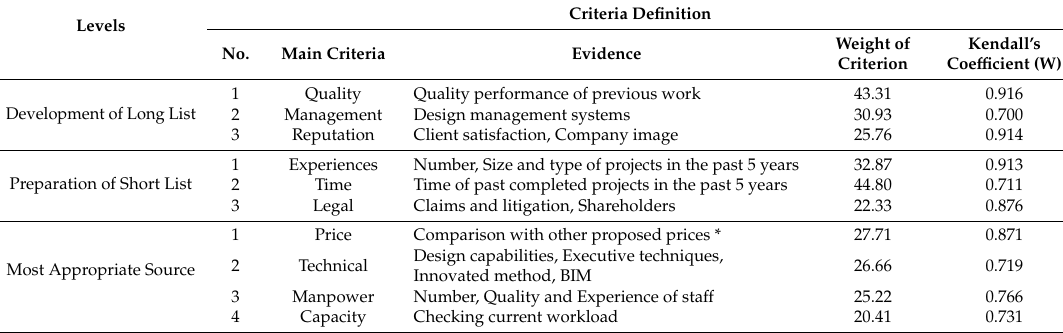
Table 8. Criteria development of Construction Consultant and their weights.